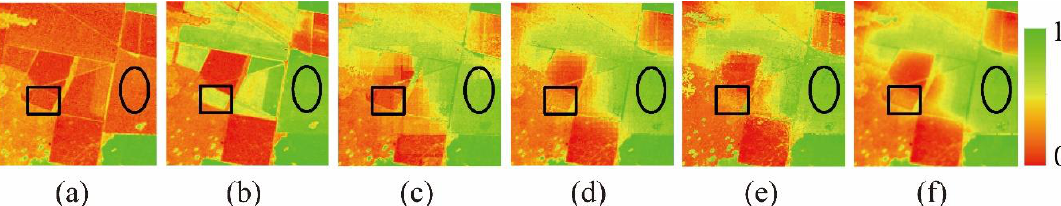
Figure 9. Visual comparison of cultivated land area. ( a , b ). Original Landsat_NDVI on 5 July and 22 August 2004; ( c – f ). Predicted Landsat_NDVI by ESTARFM, NDVI-LMGM, FSDAF and NDVI_FMHC.